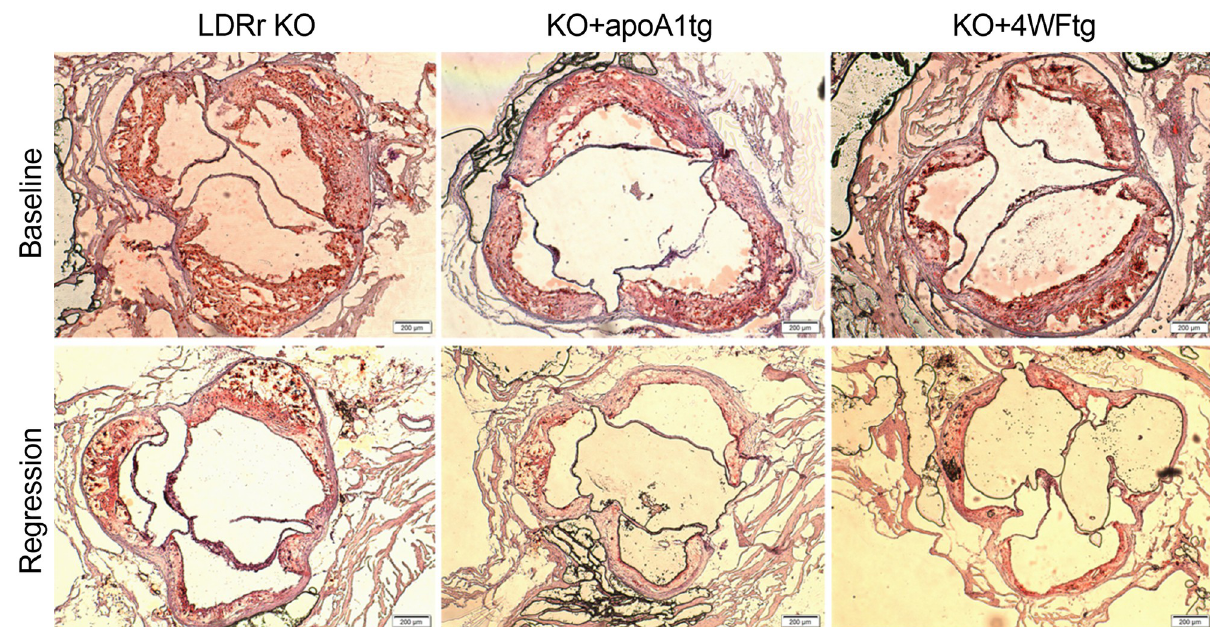
Fig 3. Aortic root lesions. Representative baseline (top) and regression (bottom) aortic root lesions from male mice of the LDLr KO (left), KO +apoA1tg (center), and KO+4WFtg (right) genotypes stained with Oil Red O and hematoxylin (4x objective lens, 200 μ m scale bar).